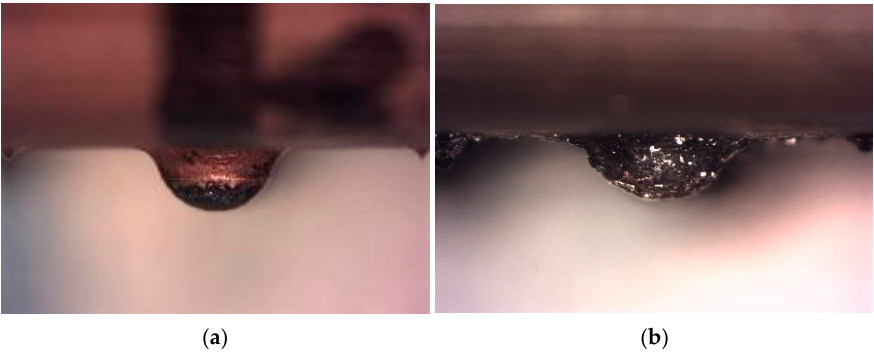
Figure 17. Semi sphere 1.1 Result after erosion. ( a ) Test 2 ( b ) Test 3.